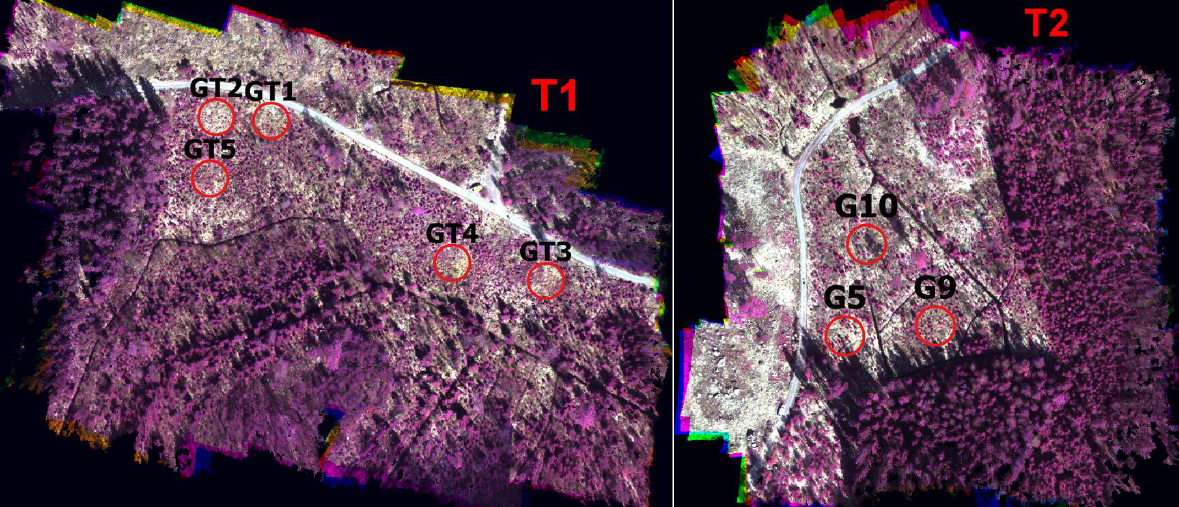
Figure 1. Seedling stand test areas T1 (left) and T2 (right), with sample plot locations. Images are FPI NIR-Red-Green